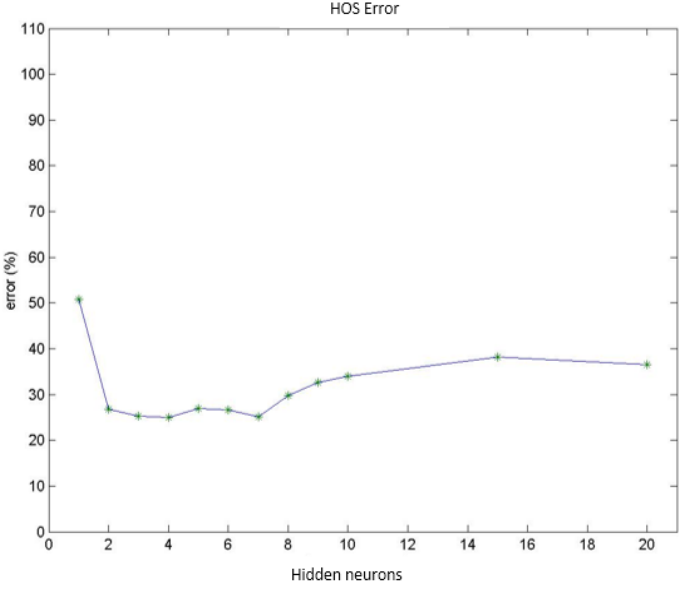
Figure 11. Diagnosis error (mean value) obtained using HOS parameters.